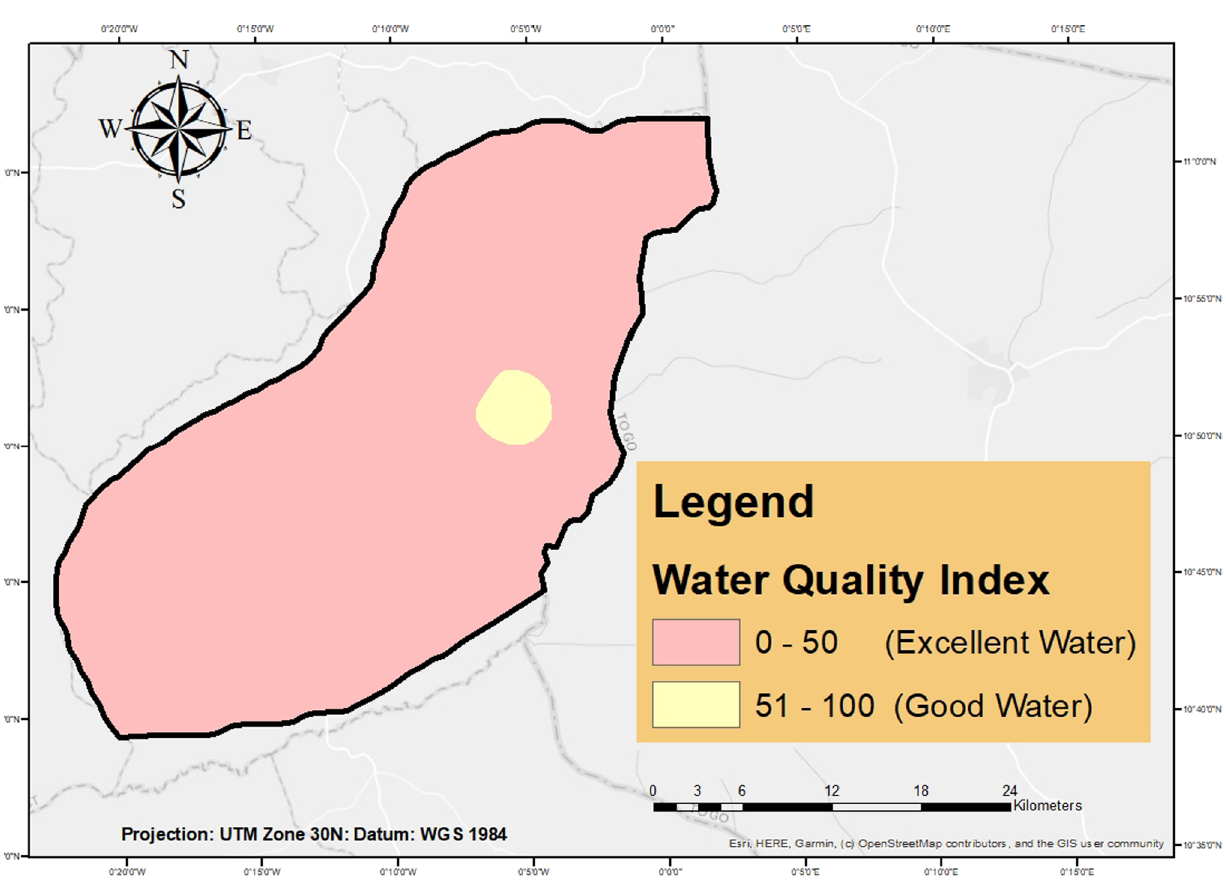
Fig. 11 Spatial water quality index distribution map of the study